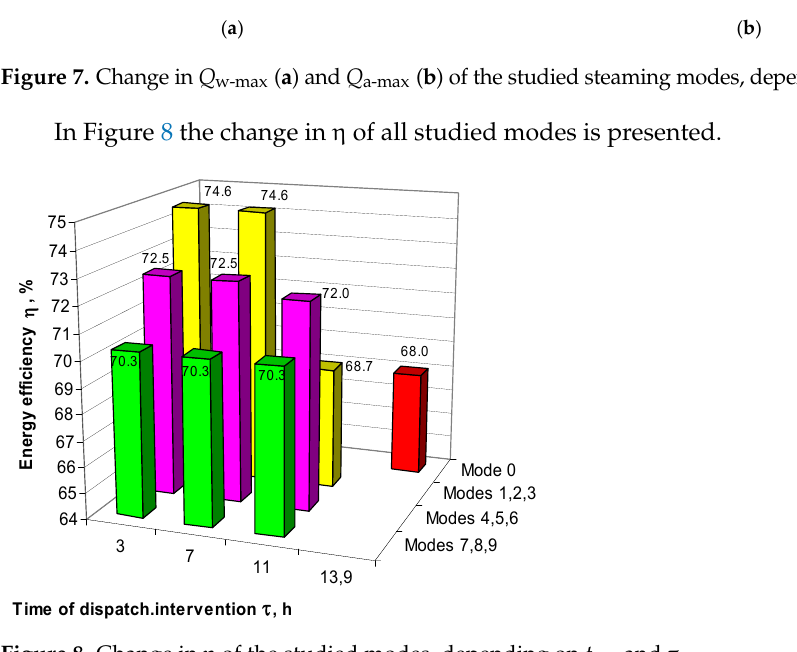
Table 2. Change in τ steam , τ mode , t w ‐ avg at τ 2 , Q w ‐ max , Q a ‐ max , and η of the studied steaming modes, de ‐ pending on Δτ .